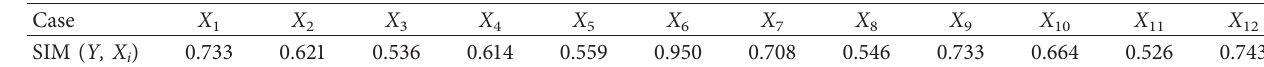
Table 4: Comprehensive case similarity.